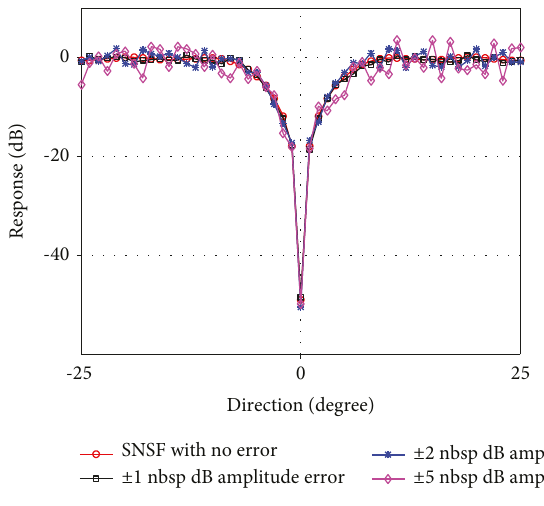
Figure 13: Response of SNSF with amplitude